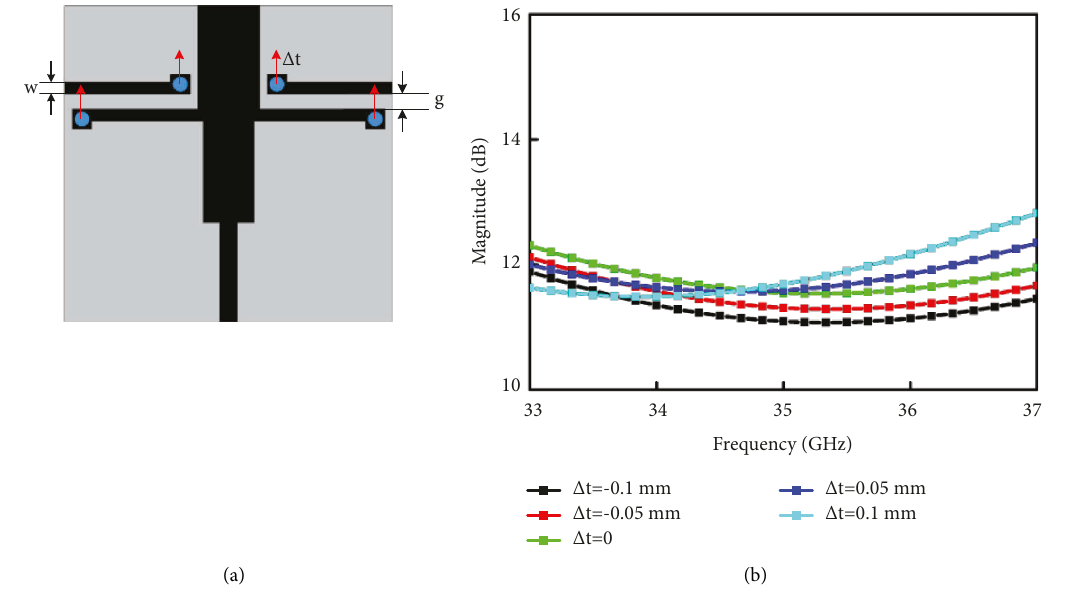
Figure 5: (a) Divider using the high-resistance line. (b) Variation of division ratio with offset error Δ t .